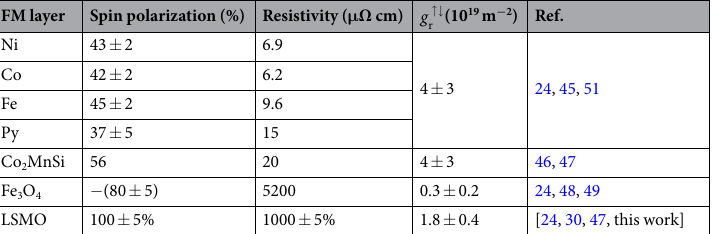
Table 1. List of parameters for various FM materials. The spin polarization was obtained with point-contact Andreev reflection measurement (ref. 45) except LSMO and Fe 3 O 4 that came from spin-resolved photoemission results (refs 30 and 48). The resistivity of single crystal Py (ref. 43), Co 2 MnSi (ref. 46) and LSMO (ref. 50) at room temperature was listed in the third column. The resistivity of Fe 3 O 4 (ref. 49) was measured for 100-nm